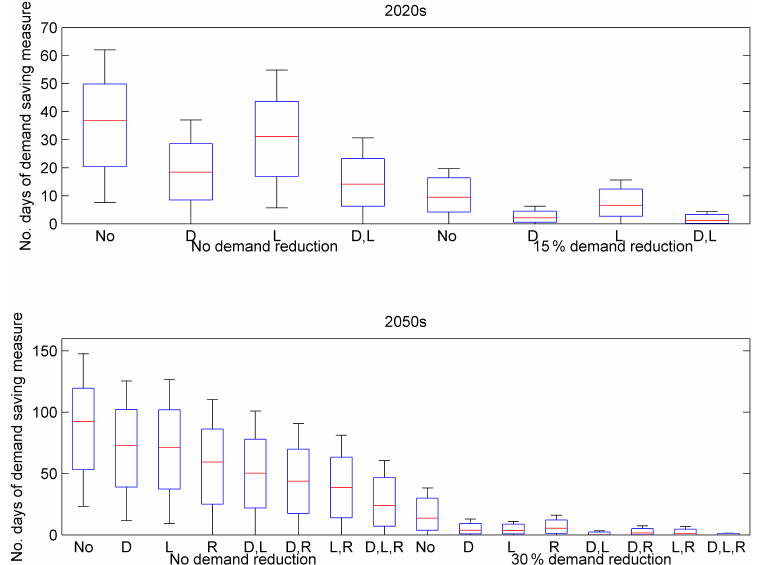
Figure 10. Number of DS4 days per 100 years for SCN20 and SCN50 under climate and population projections, given a range of supply and demand management options. No = no supply measures; D = desalination plant providing up to 150MLday − 1 ; L = leakage targets (24.2% by 2020; 18.5% by 2050); R = reservoir of 100 millionm 3 . Results are presented with no reduction in per capita demand and 15% reduction in 2020 and 30% reduction in 2050. Box plots indicate the median, 25th, and 75th percentile values; whiskers show the 10th and 90th percentile